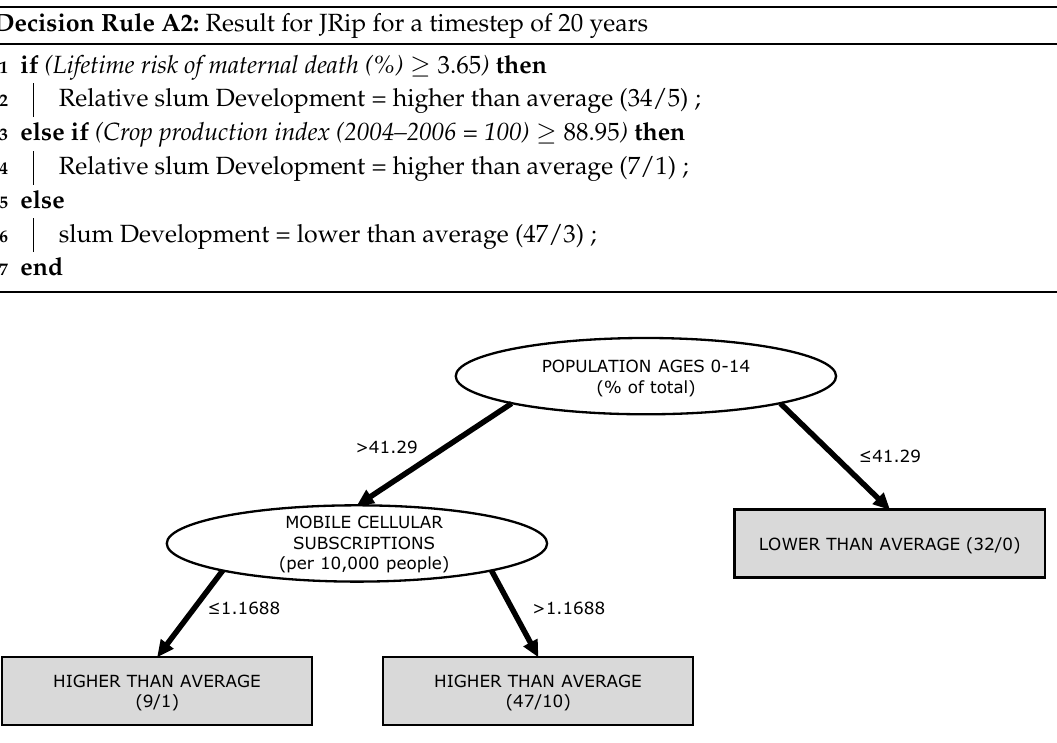
Figure A2. The model found with J48 for a timestep of 20